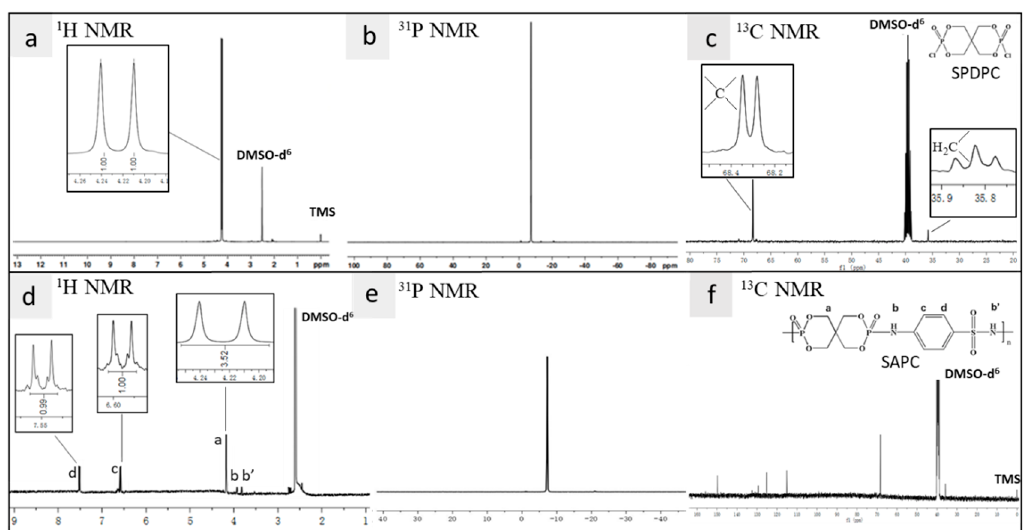
Figure 1. Fourier-transform infrared (FTIR) spectroscopy.